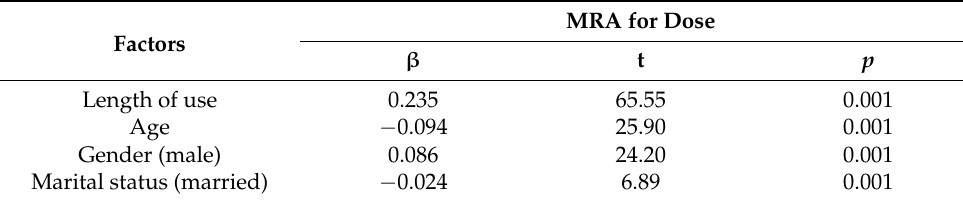
Table 4. The influence of different parameters on dose of benzodiazepines. Factors